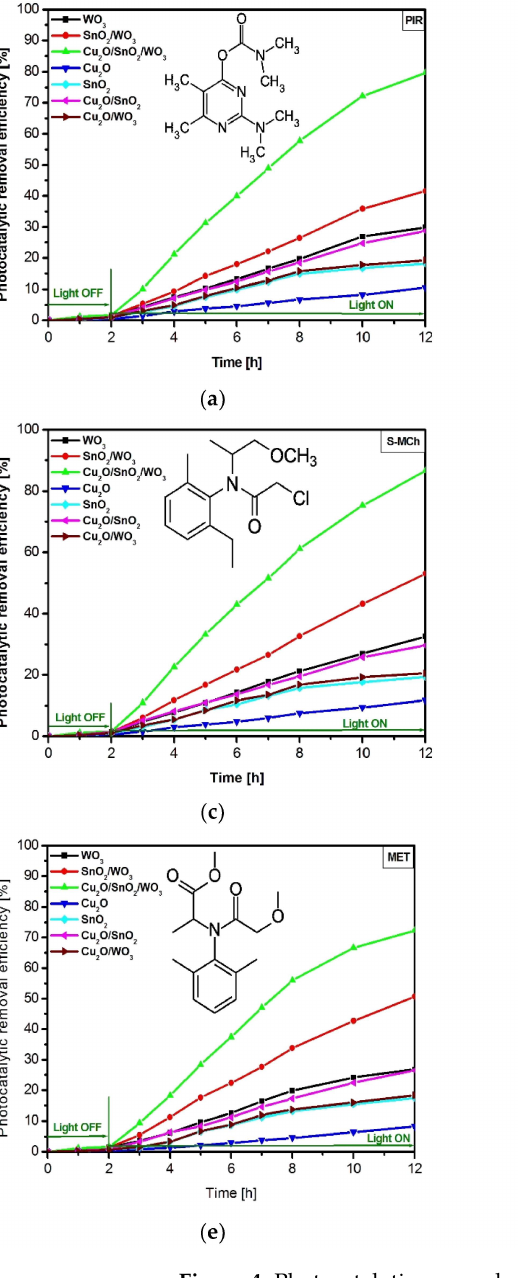
Figure 4. Photocatalytic removal efficiency and the corresponding kinetics toward PIR ( a , b ), S-MCh ( c , d ), and MET ( e , f